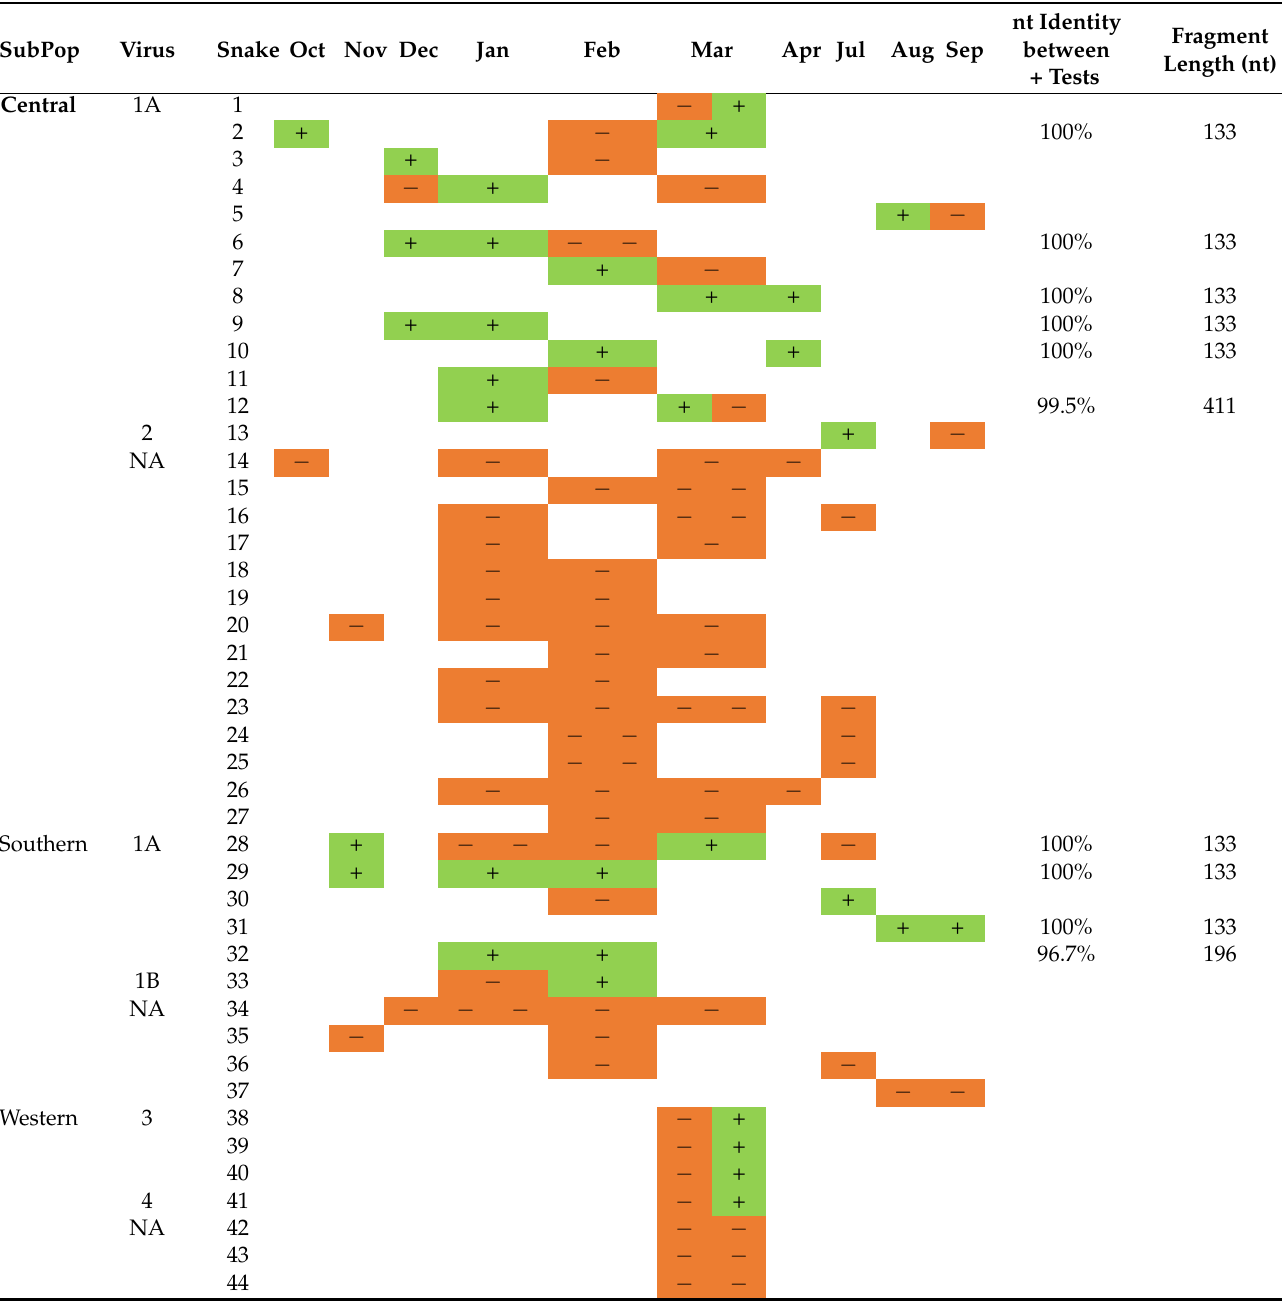
Table 4. Longitudinal serpentovirus reverse transcription PCR (rtPCR) results of 44 Burmese pythons tested two or more times originating from central, southern, and western subpopulations in southern Florida, USA. Positive tests are denoted by a green “+”, and negative tests an orange “ − ”. No snakes were tested in the months of May and June 2019. Viral clade (Virus) is shown for snakes with positive tests. In snakes with multiple positive diagnostic tests, the shared fragment length of positive diagnostic Sanger sequencing and corresponding percent of nucleotide identity are also